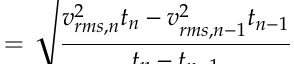
Figure 10. Velocity scatter figure.